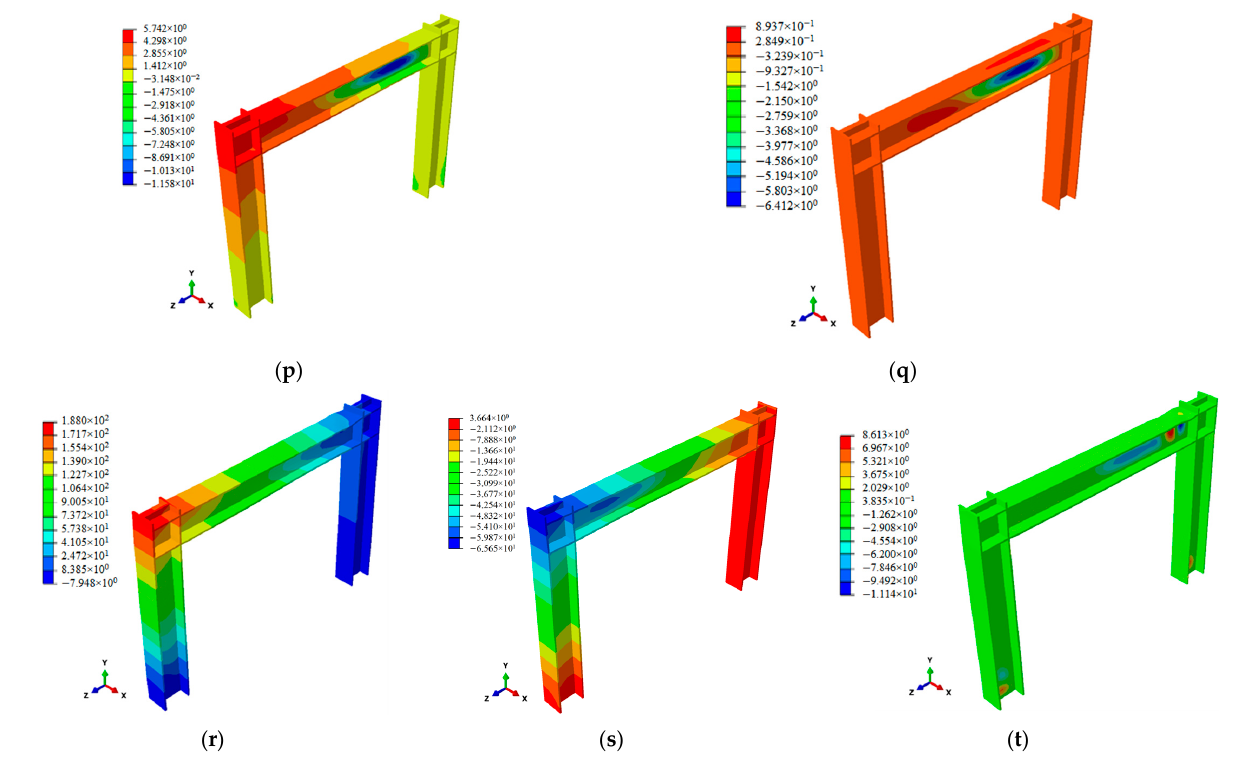
Figure 18. Out-of-plane deformation of steel plate of each SPSW model under cyclic loading: ( a ) SPSW-T at a drift ratio of 0.005; ( b ) SPSW-T-X at a drift ratio of 0.005; ( c ) SPSW-T at a drift ratio of 0.025 in push direction of the loading end; ( d ) SPSW-T at a drift ratio of 0.025 in pull direction of the loading end; ( e ) SPSW-T-X at a drift ratio of 0.025; ( f ) SPSW-N8 at a drift ratio of 0.005; ( g ) SPSW-N8-X at a drift ratio of 0.005; ( h ) SPSW-N8 at a drift ratio of 0.025 in push direction of the loading end; ( i ) SPSW-N8 at a drift ratio of 0.025 in pull direction of the loading end; ( j ) SPSW-N8-X at a drift ratio of 0.025; ( k ) SPSW-N14 at a drift ratio of 0.005; ( l ) SPSW-N14-X at a drift ratio of 0.005; ( m ) SPSW-N14 at a drift ratio of 0.025 in push direction of the loading end; ( n ) SPSW-N14 at a drift ratio of 0.025 in pull direction of the loading end; ( o ) SPSW-N14-X at a drift ratio of 0.025; ( p ) SPSW-N20 at a drift ratio of 0.005; ( q ) SPSW-N20-X at a drift ratio of 0.005; ( r ) SPSW-N20 at a drift ratio of 0.025 in push direction of the loading end; ( s ) SPSW-N20 at a drift ratio of 0.025 in pull direction of the loading end; ( t ) SPSW-N20-X at a drift ratio of 0.025.